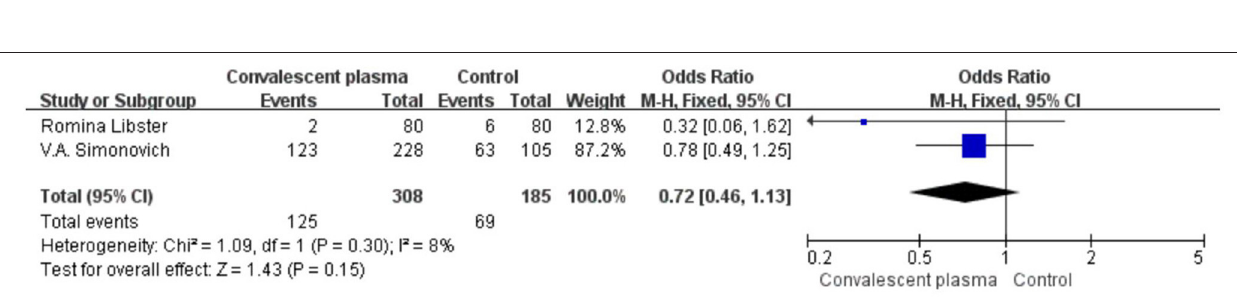
FIGURE 9 | Forest plot of the rate ICU admission among patients treated with convalescent blood products and controls ( n = 2 studies). Weights are from fixed-effects analysis. CI, confidence interval; ICU, intensive care unit.